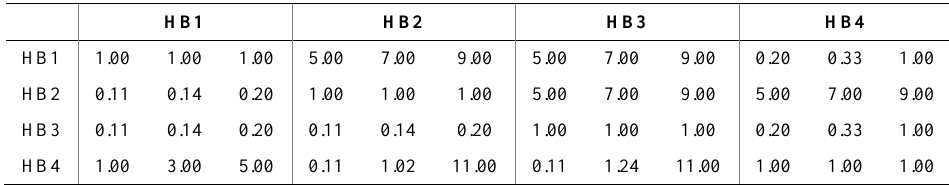
Table 5. Fuzzy Matrix Obstacles Process/Business Criteria One Expert